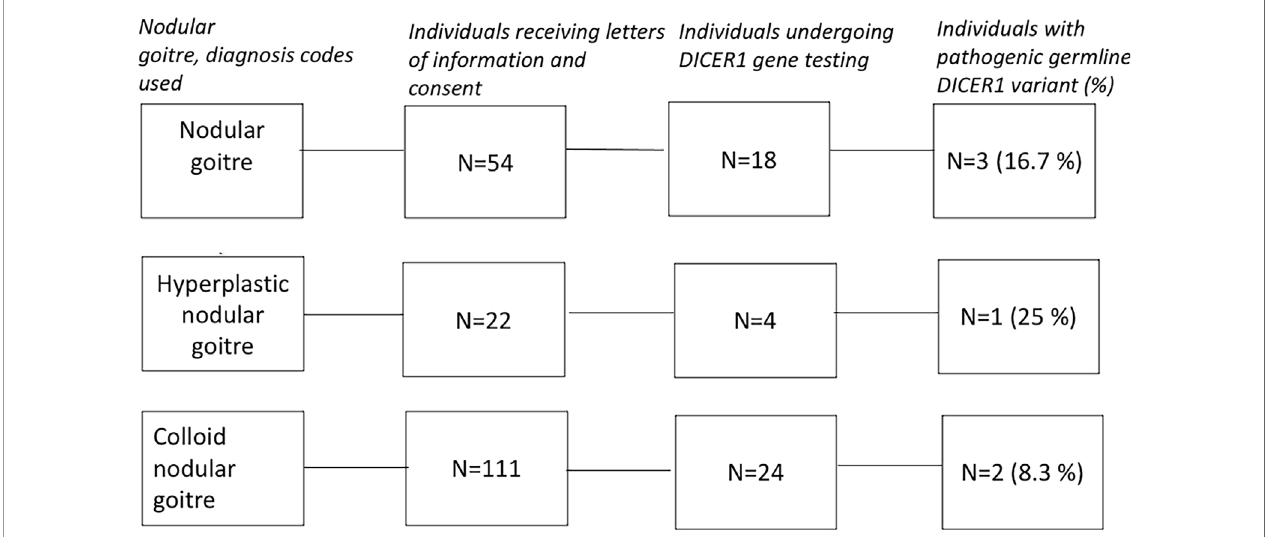
FIGURE 1 | Schematic representation of the method used to obtain